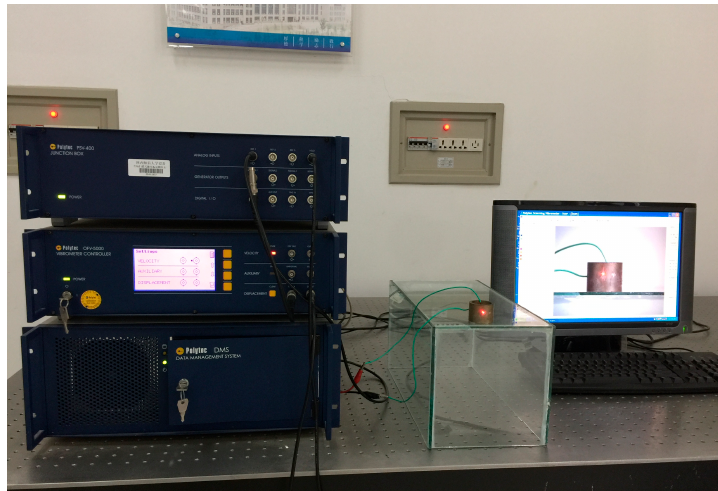
Figure 6. Experimental setup for the measurement of the radially polarized piezoelectric cylindrical transducer.